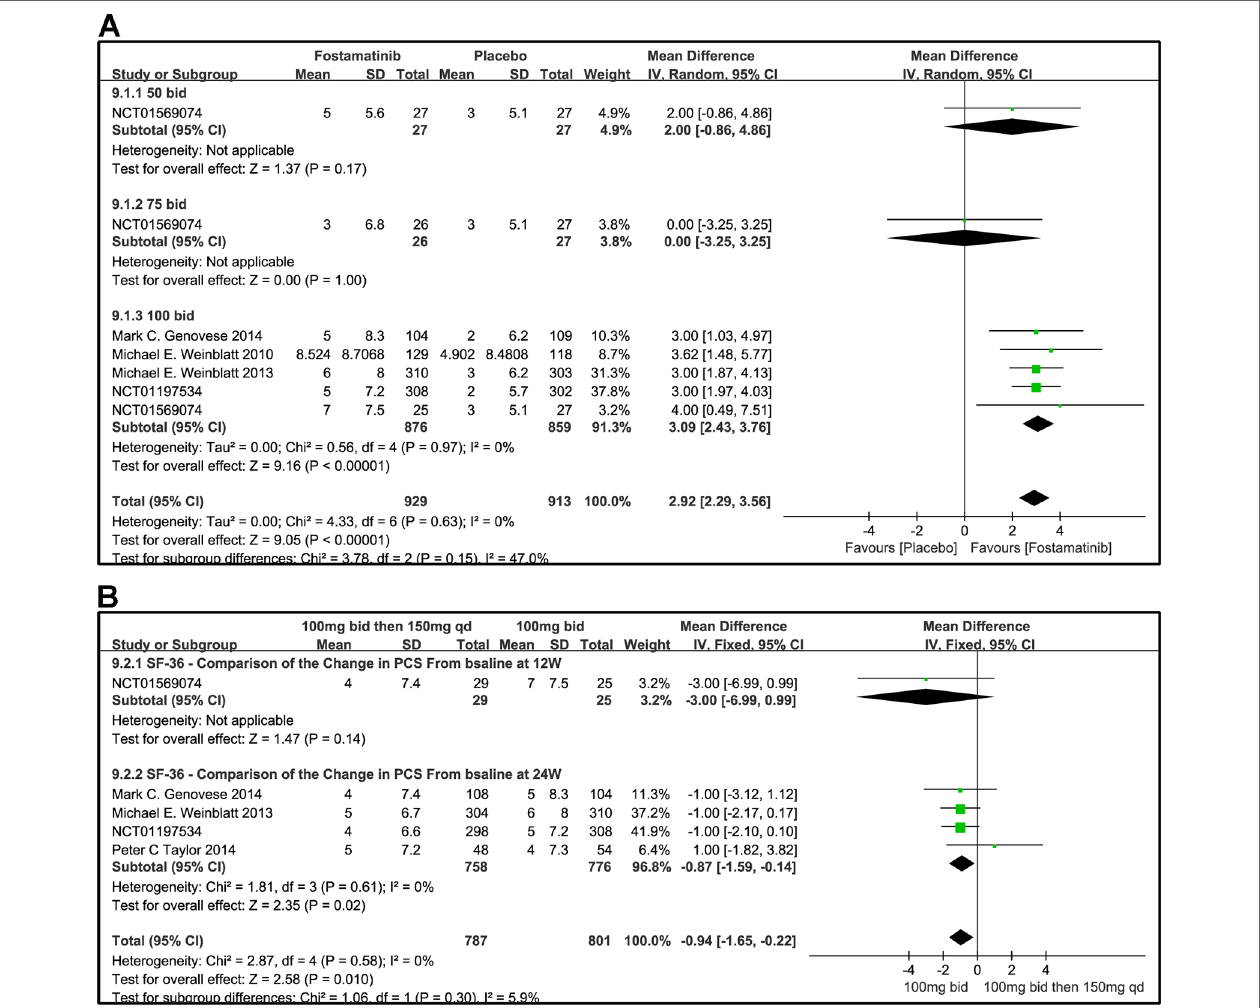
FIGURE 10 | Forest plots for the effect of multiple doses on SF-36 to derive the change in PCS at different time points. (A) Subgroups administered multiple doses (50, 75, and 100 mg bid) of fostamatinib vs. placebo at 24 weeks; (B) 100 mg bid for 4 weeks followed by 150 mg bid vs. 100 mg bid at 12 and 24